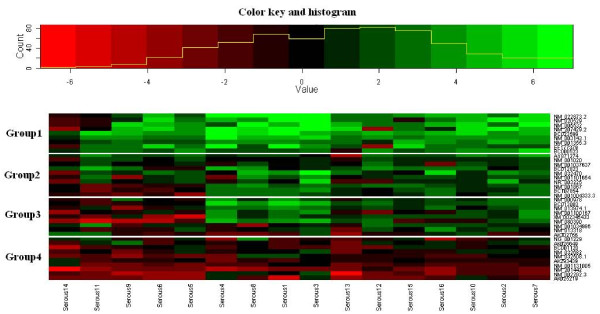
Clustering of the log2 expression ratios of the cancer to normal samples measured by the quantitative real-time PCR for the 38 DEGs from the 16 patients and its representation as a heat map. Patients are ordered along the X-axis and genes along the Y-axis.